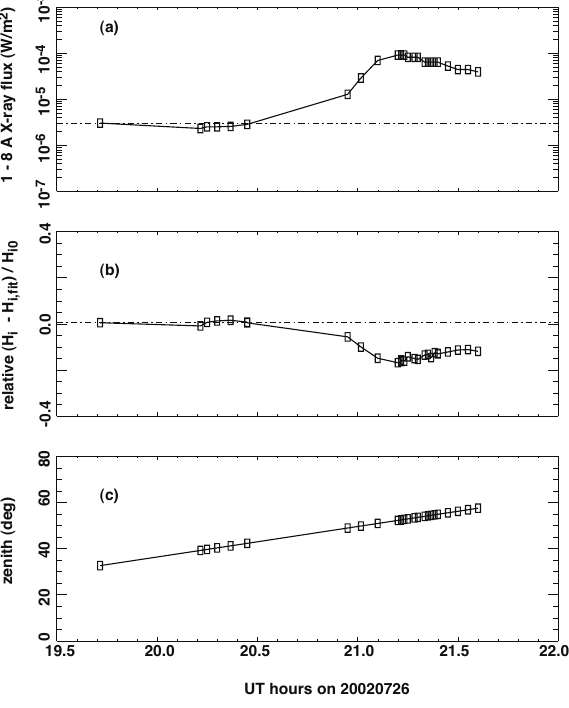
Fig. 10. For a typical data cluster (see text), time series of (a) long- wave X-ray flux density, (b) relative dimensionless height (see text), and (c) solar zenith angle at ground. Each symbol is for the time of a single height